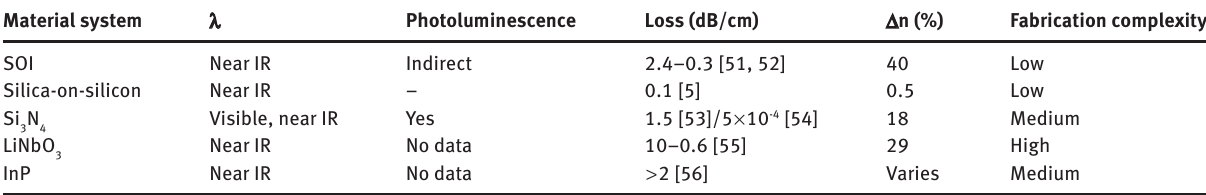
Table 1: Summary of integrated photonics platform parameters. Material